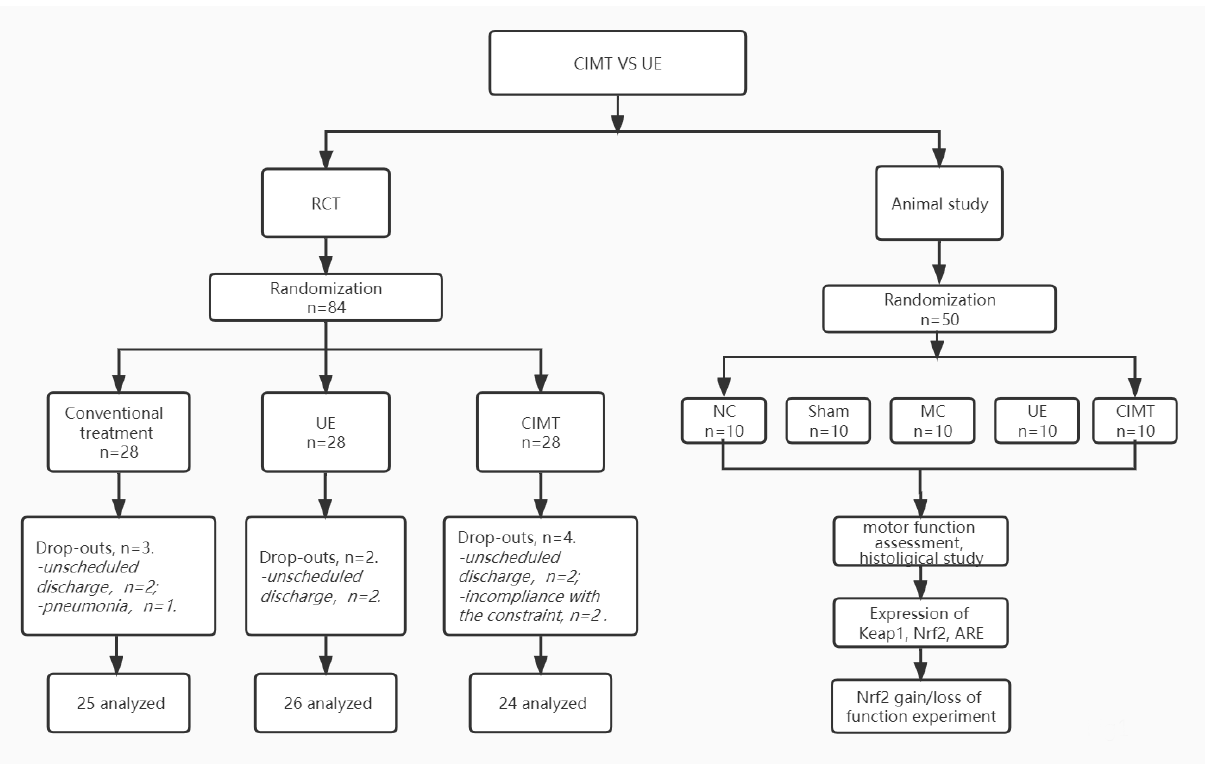
Figure 1. Flowchart of the clinical randomized controlled trial and animal experiment.